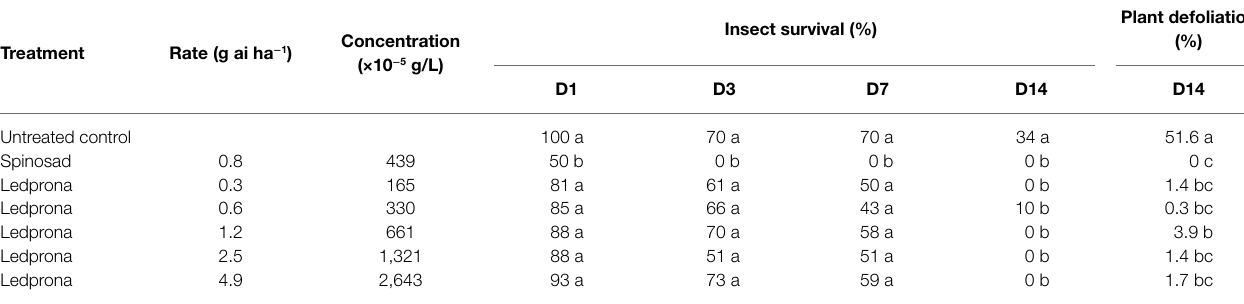
TABLE 3 | Percent survival of CPB larvae and whole plant defoliation following Ledprona application in the greenhouse.